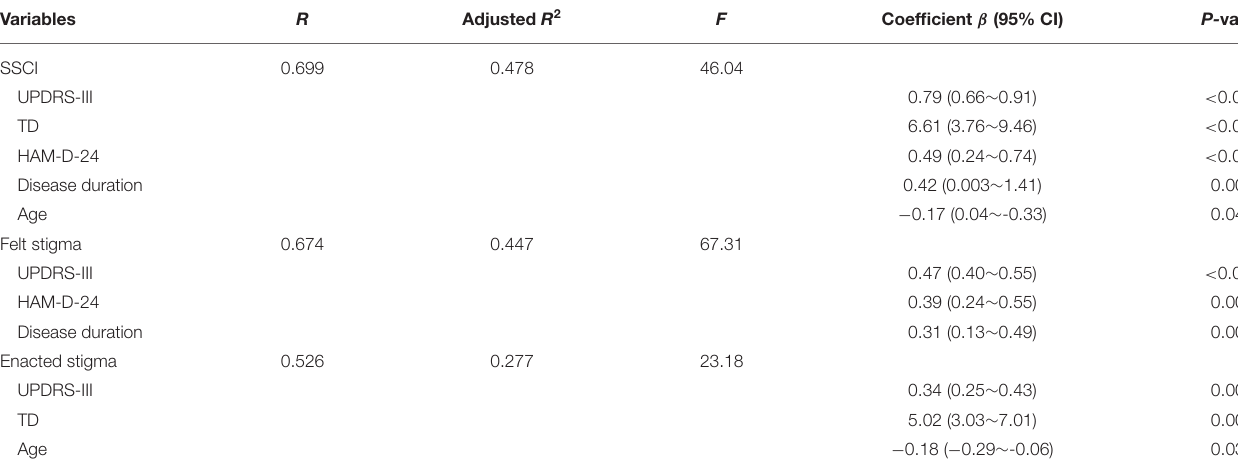
TABLE 2 | Multivariate linear regression model of factors associated with SSCI.